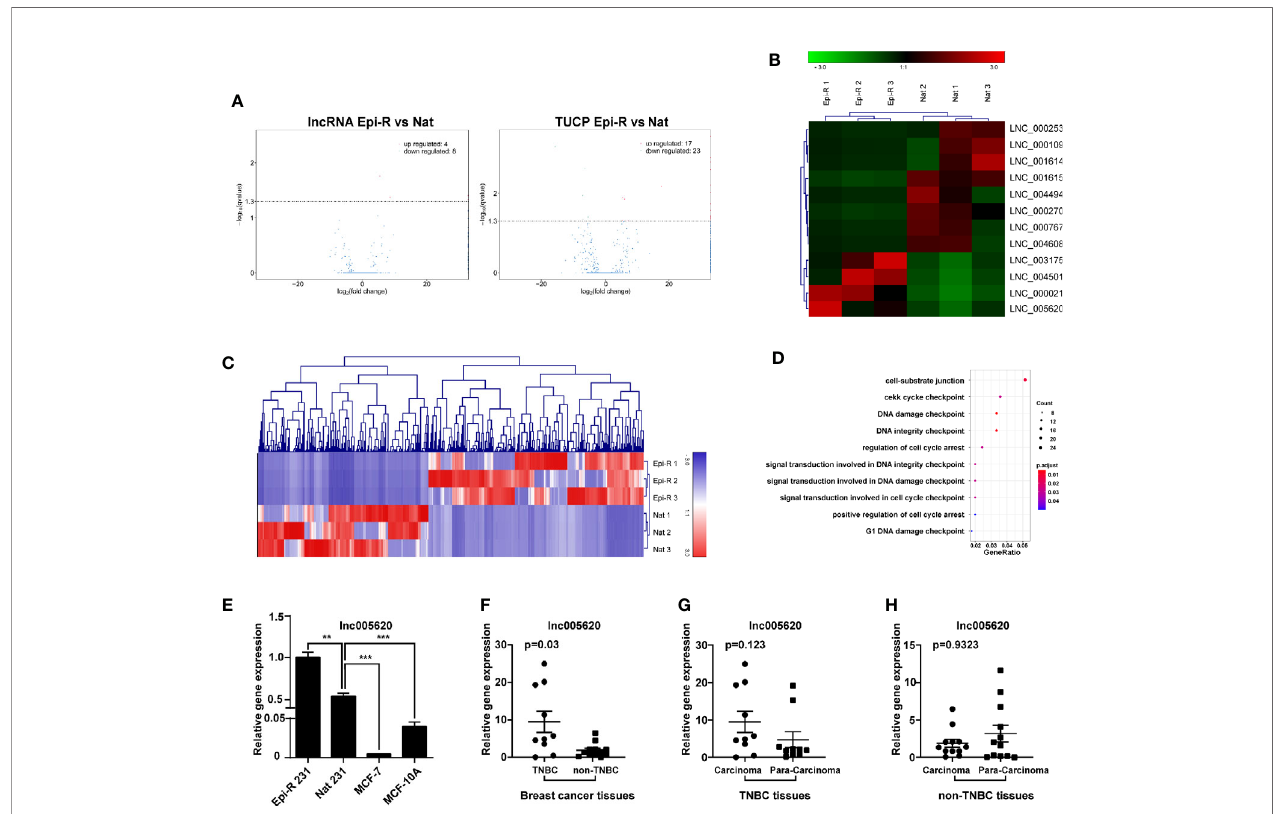
FIGURE 2 | Identi fi cation of novel lncRNAs in epirubicin-resistant MDA-MB-231 cells. Epirubicin-resistant (Epi-R) and native (Nat) MDA-MB-231 cells were used for RNA sequencing analysis. (A) Volcano plots of differentially expressed lncRNAs and transcripts of uncertain coding potential (TUCPs) between Epi-R and Nat cells. (B) Hierarchical cluster analysis diagram of 12 novel differentially expressed lncRNAs. n = 3. (C) Hierarchical clustering analysis diagram of 521 coexpressed genes of lnc005620. (D) GO functional enrichment analysis of 521 genes coexpressed with lnc005620. n = 3. (E) RT-qPCR validation of lnc005620 expression in Epi-R and Nat MDA-MB-231 cells, MCF-7 cells and MCF-10A cells. n = 3. (F – H) RT-qPCR analysis of lnc005620 expression in breast cancer tissues and paired adjacent non ‐ tumor tissues from TNBC (n =10) and non-TNBC (n = 12) patients. Data are represented as the mean ± SD, ** P < 0.01, *** P <